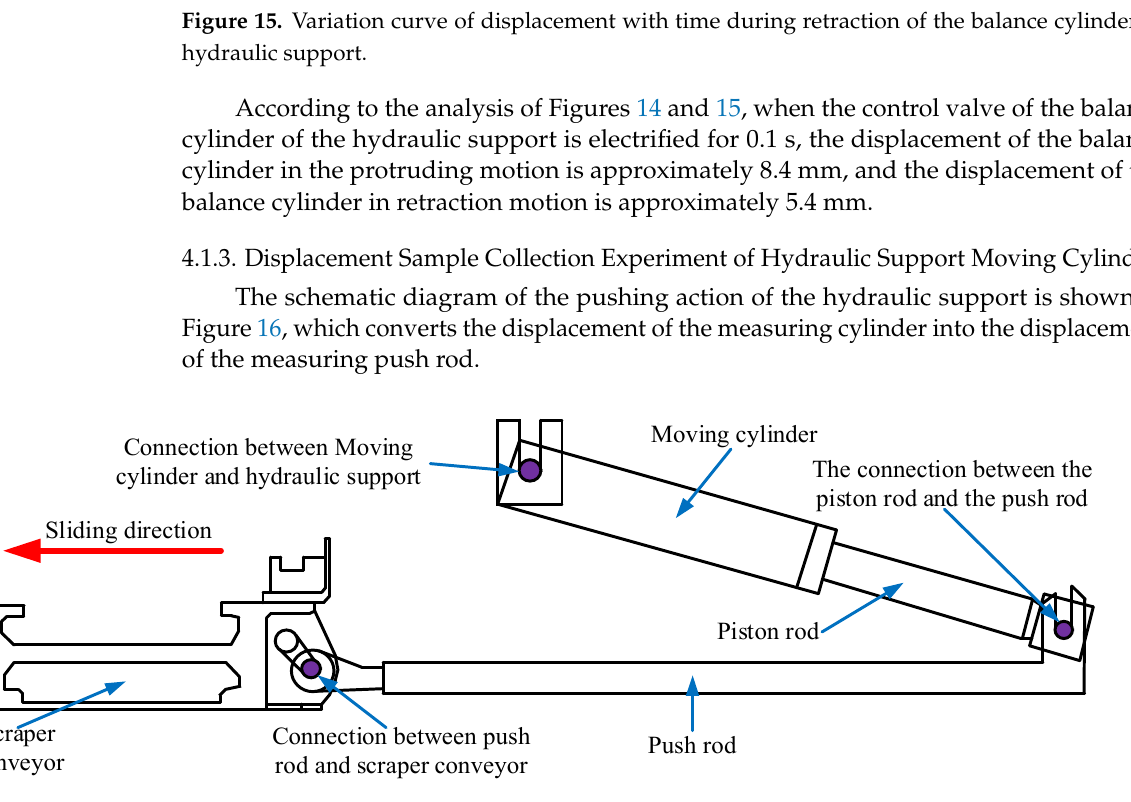
hydraulic support.